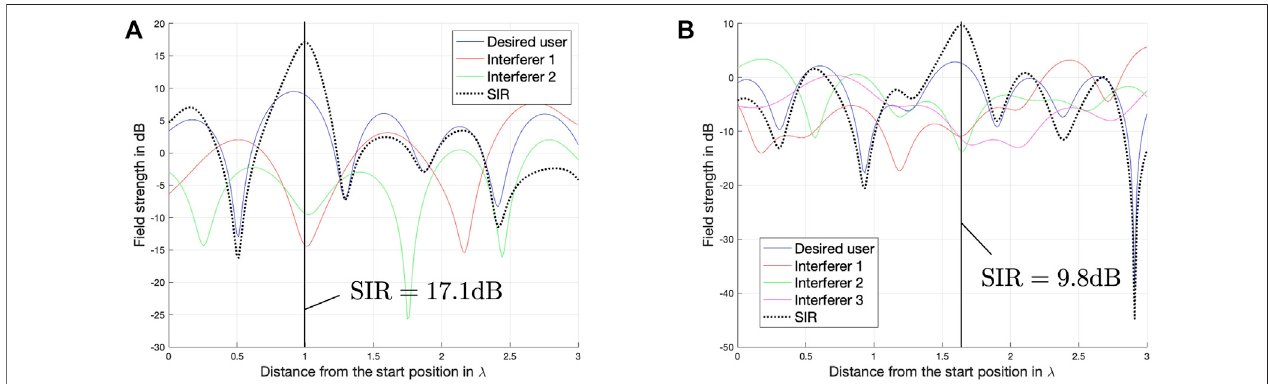
FIGURE 11 | Examples of fading envelopes over a FAMA system with (A) three users or (B) four users.